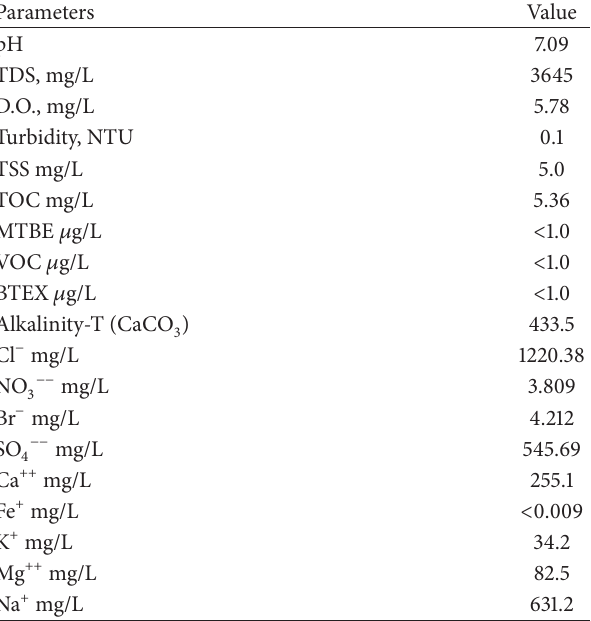
Table 1: Characteristics of groundwater